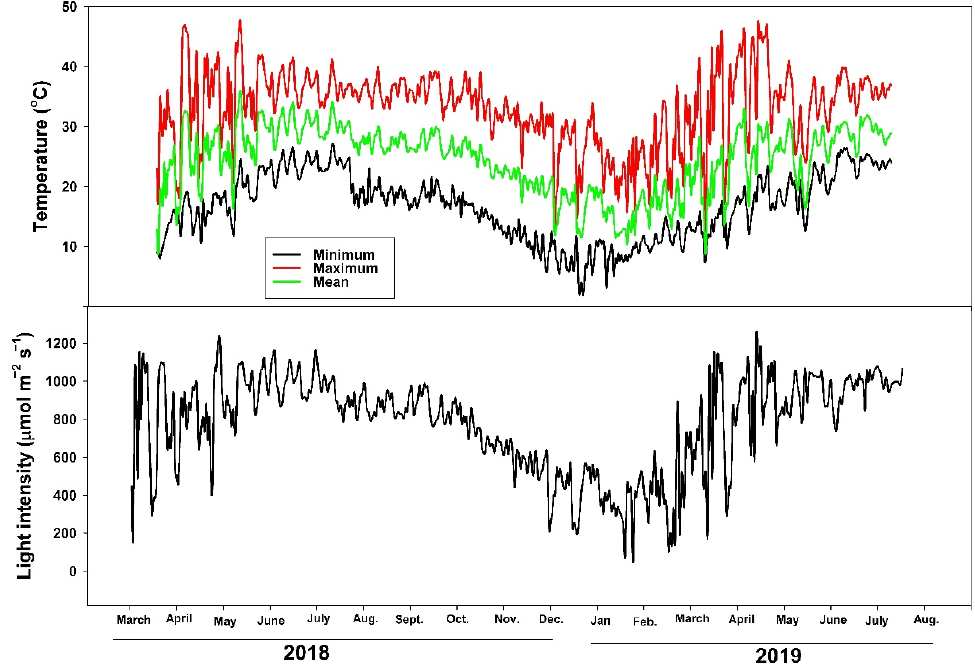
Figure 1. Maximum, minimum, and mean air temperature and light intensity during the study pe- riod.